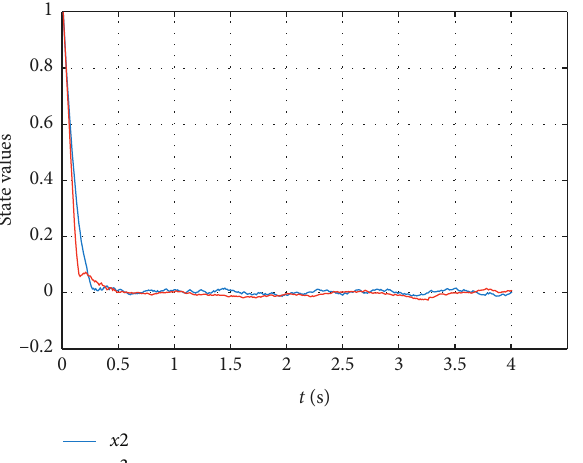
Figure 9: Initial disturbance response of system.